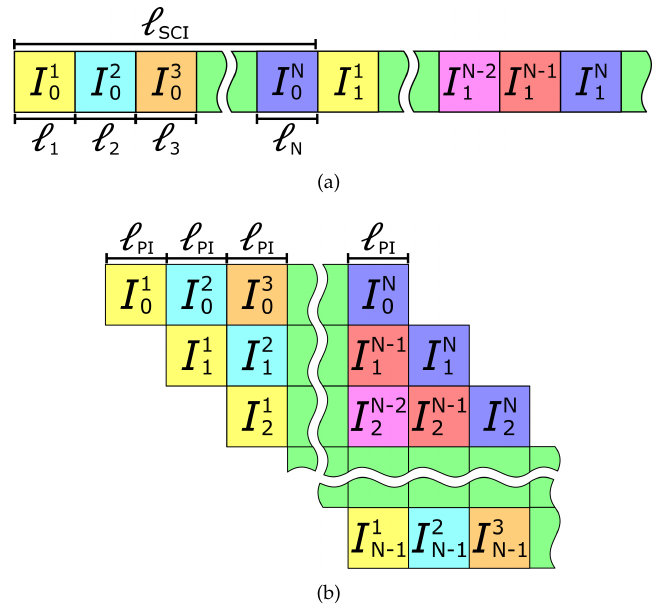
Figure 1. Execution techniques: ( a ) Nonpipeling. ( b )